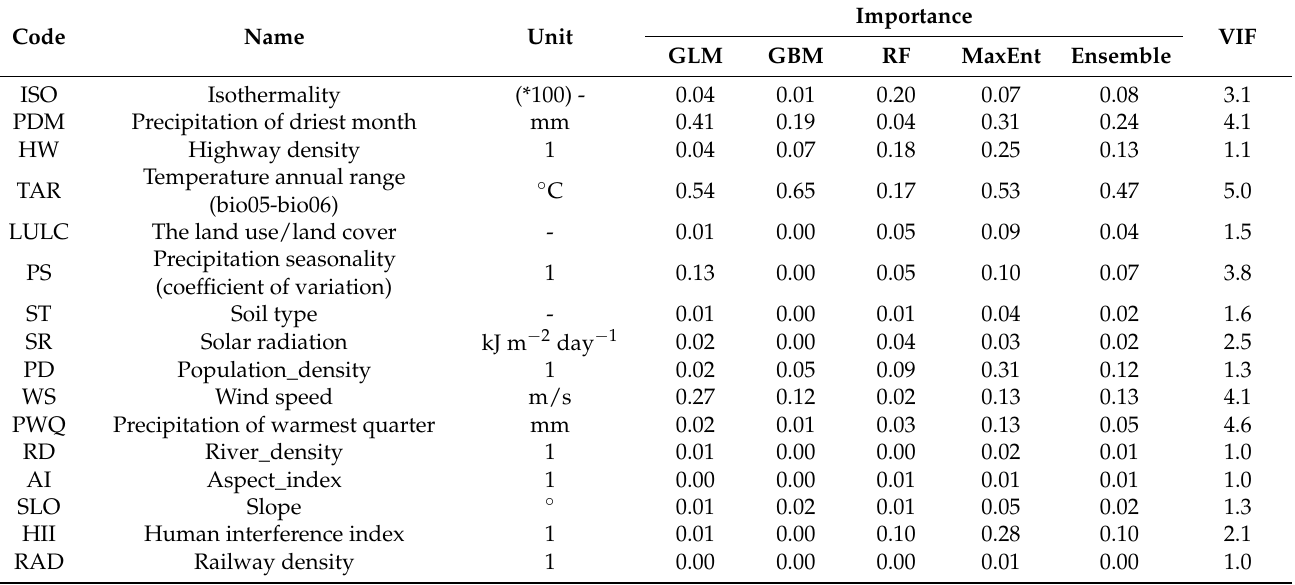
Table 1. Permutation importance of the variables used in the modeling for A. adenophora (resolution: 1 km × 1 km).